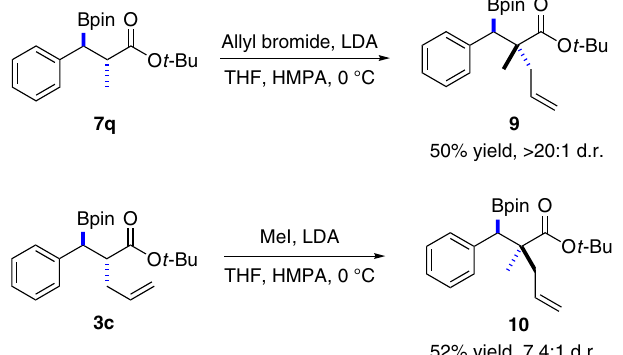
Fig. 5 Construction of tertiary – quaternary stereocenters. Preparation of the diastereoisomers 9 and 10